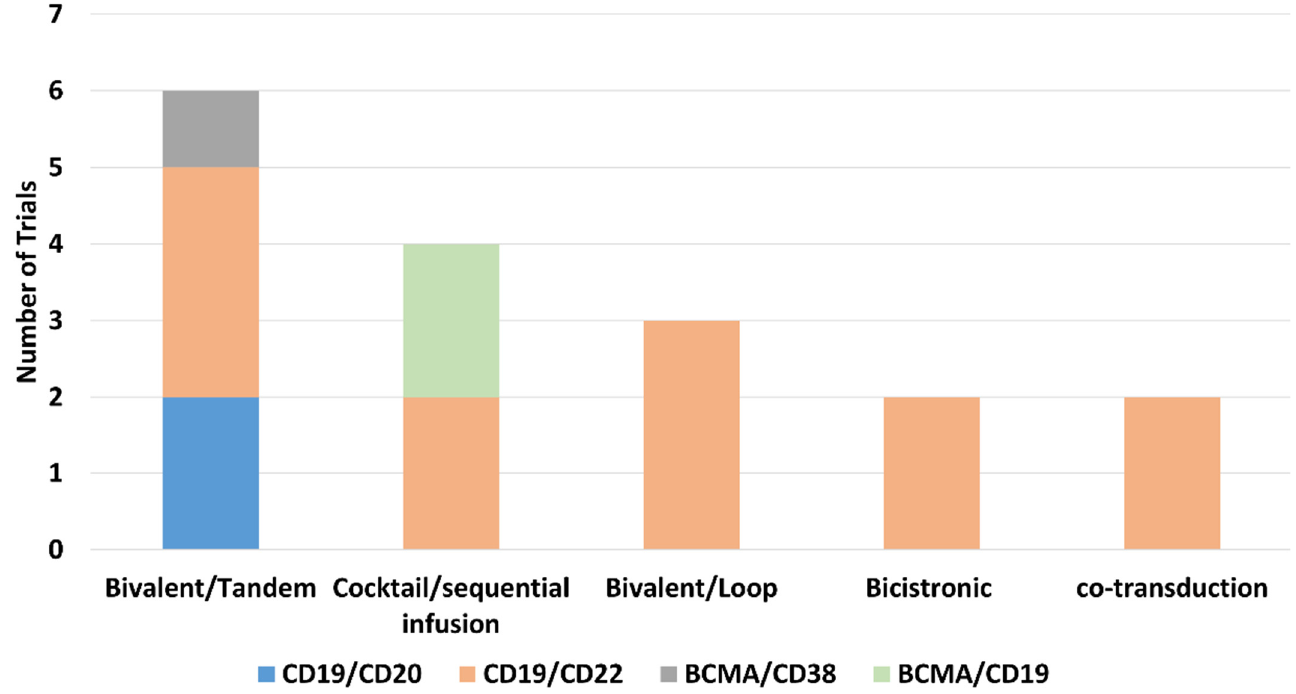
Figure 2. Clinical trials of different dual-targeting CAR T-cell therapies. Different dual CAR strategies have been translated into six clinical trials on Tandem Bi-CART targeting CD19/CD20, CD19/CD22, and BCMA/CD38; four trials on cocktail/sequential infusion of two separate Si-CAR-T products on CD19/CD22 Si-CART and BCMA/CD19 Si-CART; three trials on Loop Bi-CART targeting CD19/CD22; two trials on bicistronic Bi-CART targeting CD19/CD22; and two trials on CD19/CD22 Bi-CART produced by co-transduction of two separate vectors. The bar chart was created